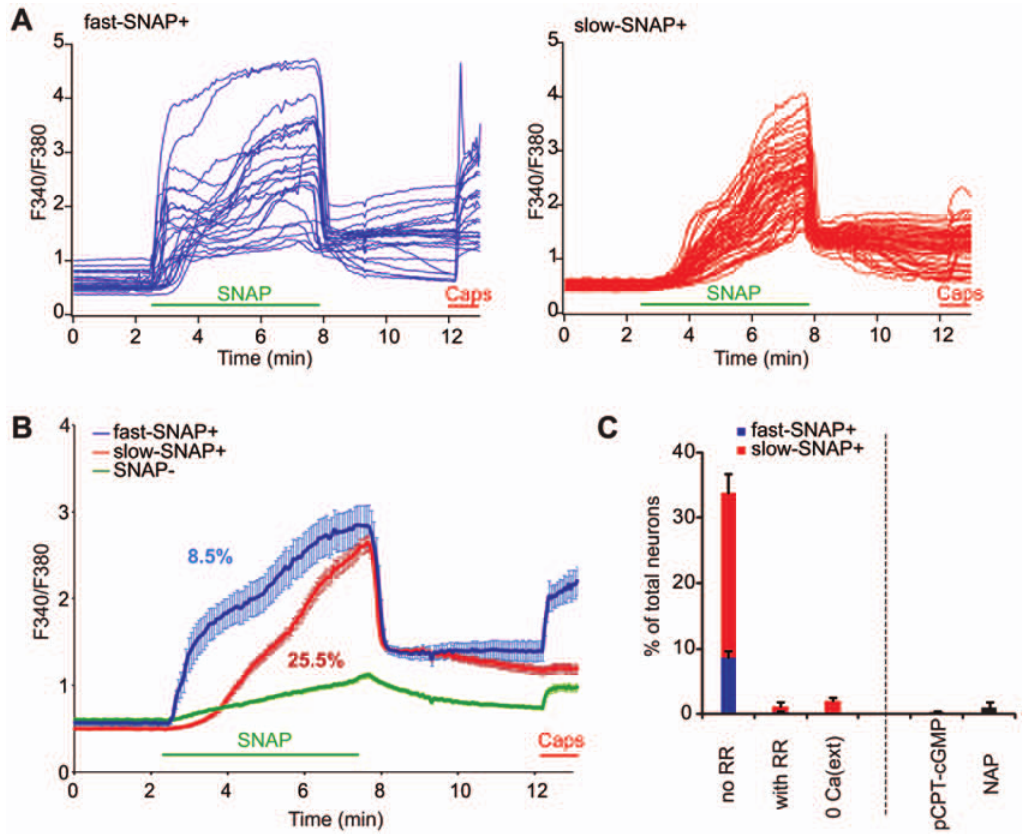
Figure 1. NO donor activates primary cultured DRG neurons. (A, B) Responses of primary cultured DRG neurons assessed by ratiometric calcium imaging. Fluorescent ratios (F340/F380) of individual neurons (A) and averaged traces (B) are shown. Fast-SNAP + neurons display significantly increased intracellular calcium upon NO donor application within one minute (blue traces), and slow-SNAP + neurons after one minute (red traces). Neurons without significant increases in intracellular calcium are also shown (B, green trace). Proportions of fast- and slow-SNAP + in (B) are shown as percentages. DRG neurons were challenged with SNAP (3 mM) for 5 min (green bar). Capsaicin (Caps, 10 m M, red bar) was applied at the end as a control. (C) Summary of responses of primary cultured DRG neurons assessed by ratiometric calcium imaging. Proportions of neurons activated by SNAP (three left columns; subdivided into fast-SNAP + (blue) and slow-SNAP + (red) responders), and pCPT-cGMP (2 mM) and NAP (3 mM; non-NO releasing isomer of SNAP) (two right black columns) are shown. SNAP induced intracellular calcium responses were sensitive to Ruthenium red (‘‘with RR’’) and required extracellular calcium (‘‘0 Ca(ext)’’). Cells were exposed to RR (10 m M) and calcium depleted saline 3 min prior to and throughout SNAP application and washed out prior to capsaicin addition. The proportion responsive to capsaicin was normal in these